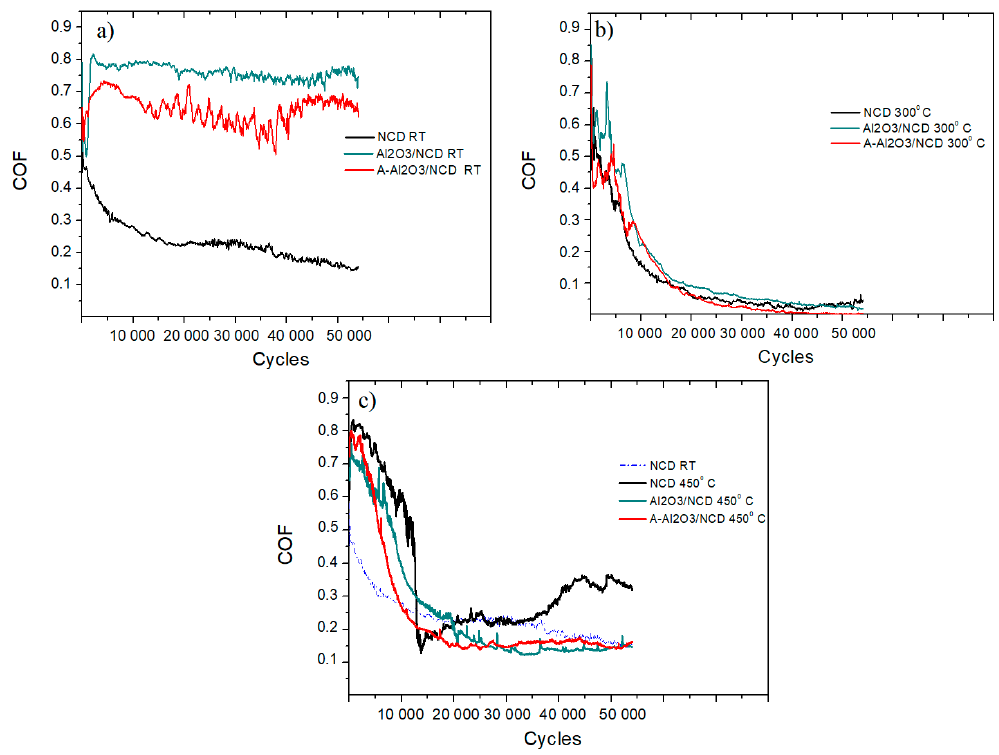
Figure 3. COF vs number of cycle curves taken on the NCD, Al 2 O 3 / NCD and A-Al 2 O 3 / NCD films at ( a ) RT, ( b ) 300 °C and ( c ) 450 °C.